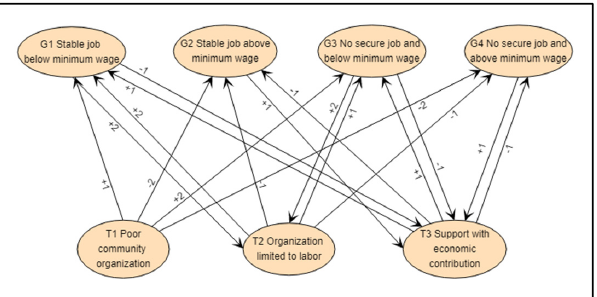
Figure 4. Exemplary network inter-relationship between two descriptors and its states. It shows the influence (promotes: + or hinders: − and its degree (here: − 2 . . . 2). Descriptor G can exert influence on descriptor T (active), and at the same time descriptor G can be influenced by descriptor T